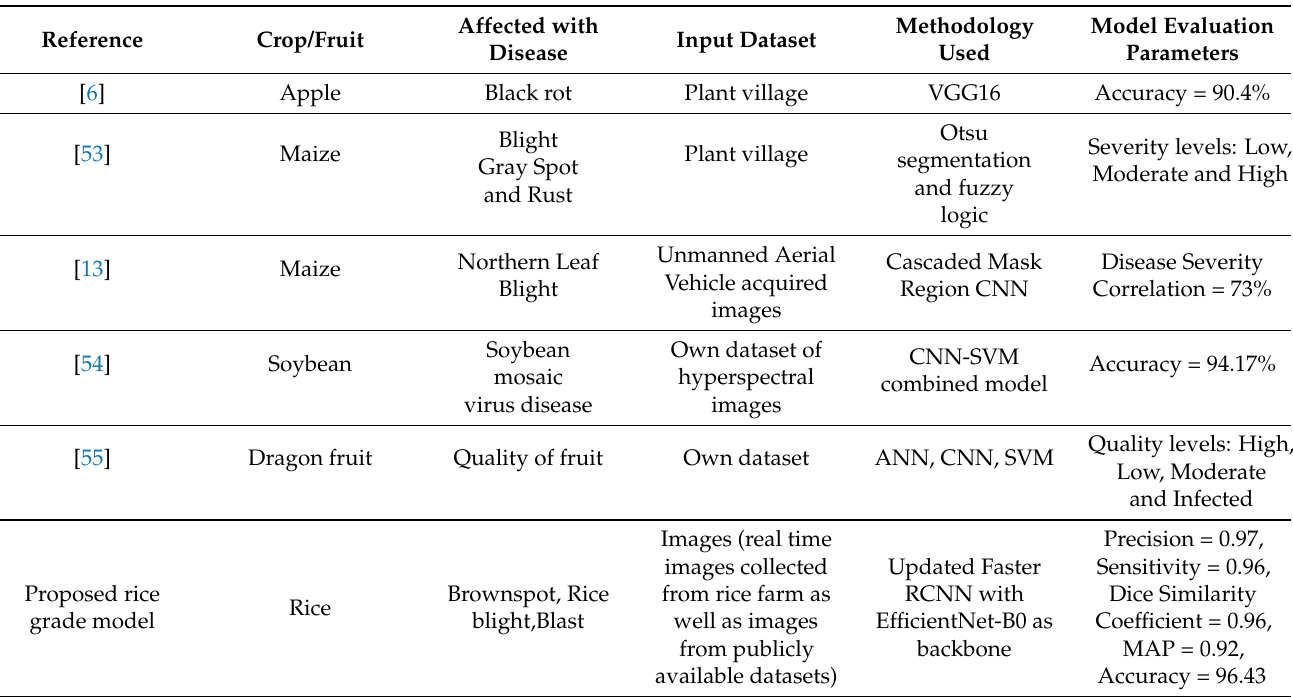
Table 7. Comparison of rice grade with the state-of-the-art crop disease severity estimation tech-